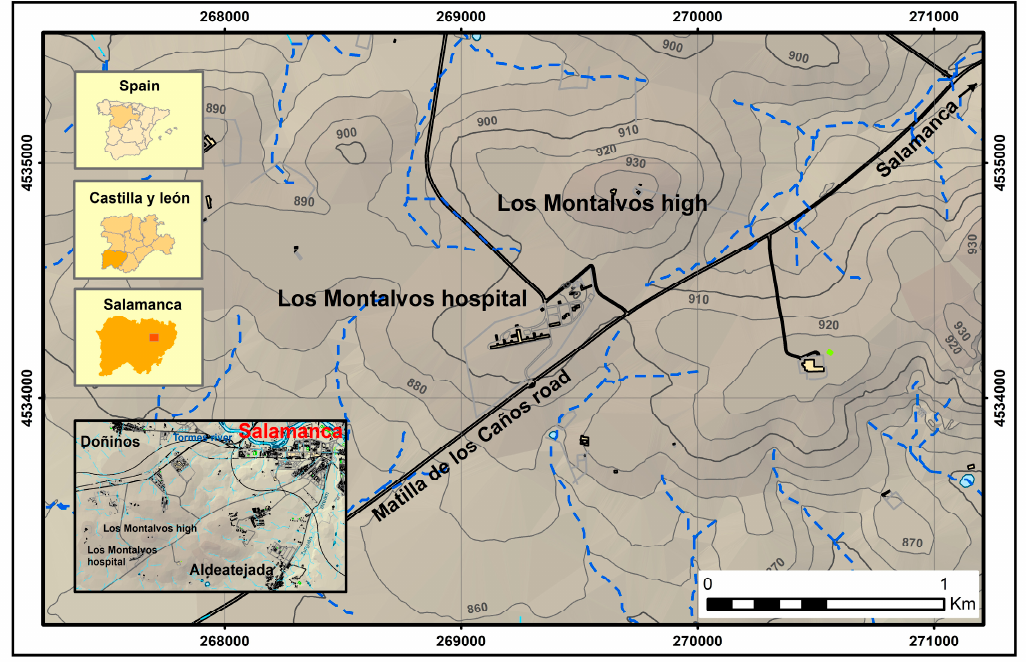
Figure 1. Study area and topographic map (dashed lines: drainage network).